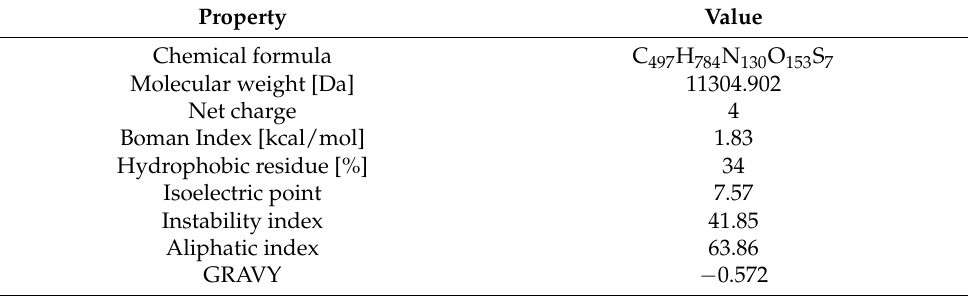
Table 2. Chemical and physical properties of S100A15